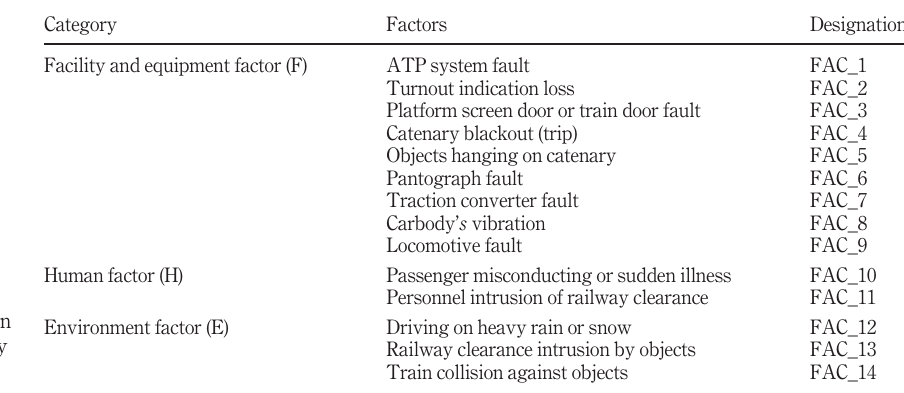
Table 1. Factors resulting